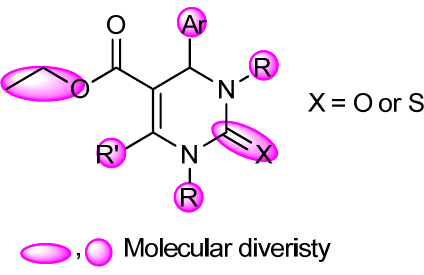
Figure 1. The design of a bioactive dihydropyrimidinones (DHPMs) scaffold has many variables and parts.